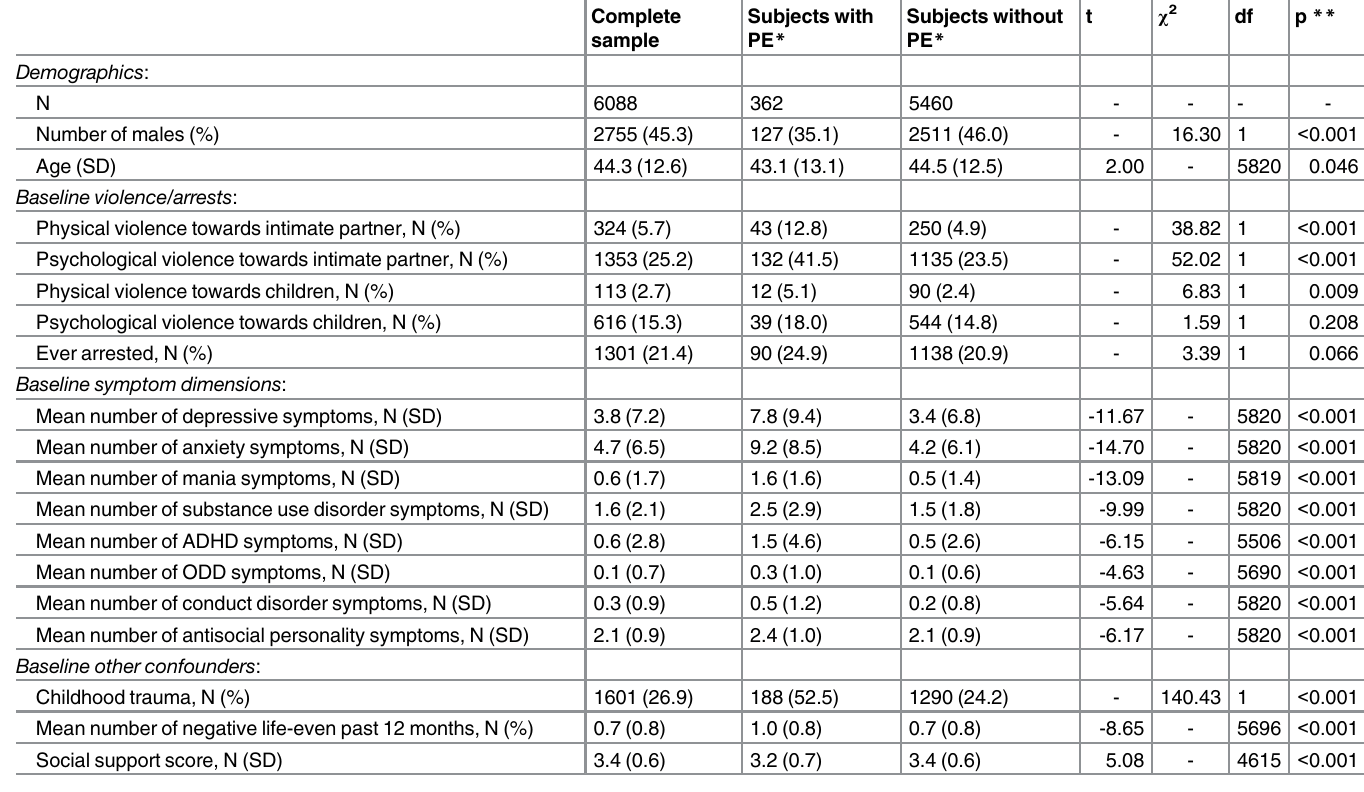
Table 1. Baseline